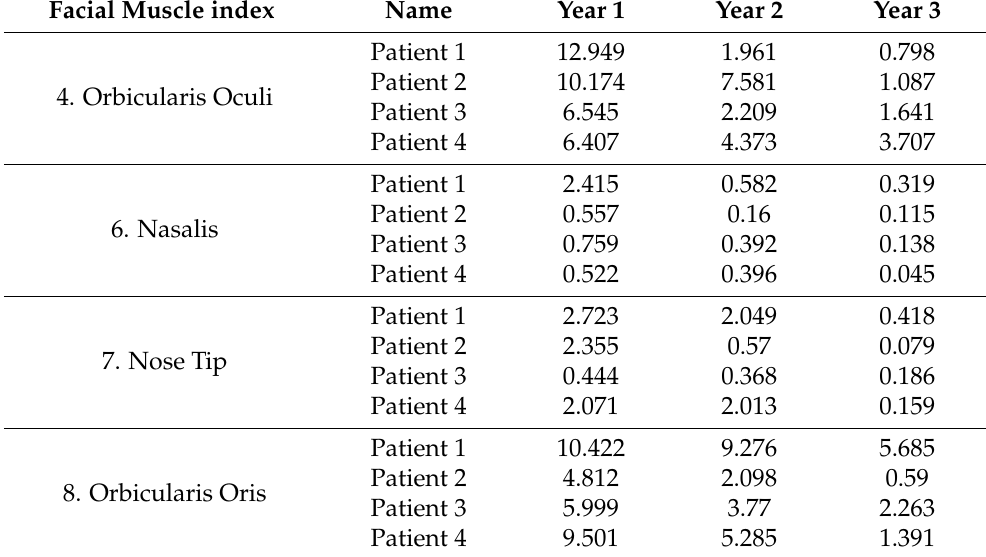
Table 8. Results for the amount of landmark movement of each facial muscle for patients by year in dynamic